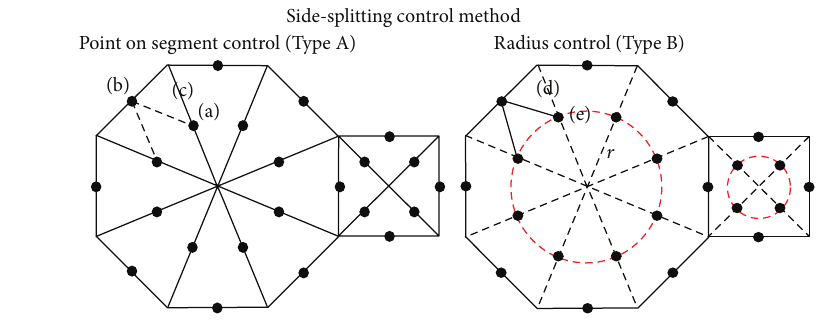
Figure 19: Side-splitting control method diagram.